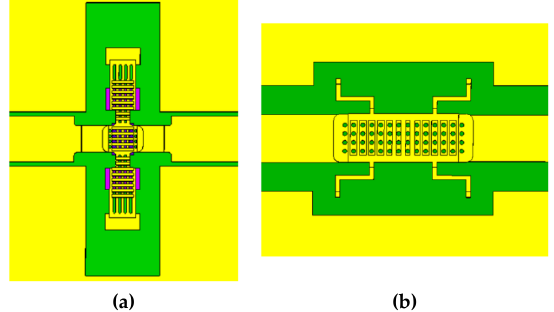
Figure 2. Schematic of the transverse ( a ) and longitudinal ( b ) Micro-Electro-Mechanical Systems (MEMS) membrane integrated into the Coplanar Waveguide (CPW) transmission line and employed in the K and Ka band phase shifters designs, respectively.